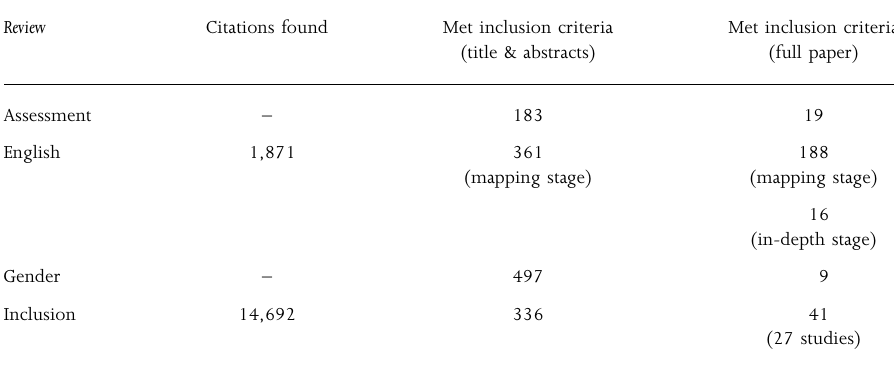
Table 2 Finding reliable evidence: the first four EPPI-Centre systematic